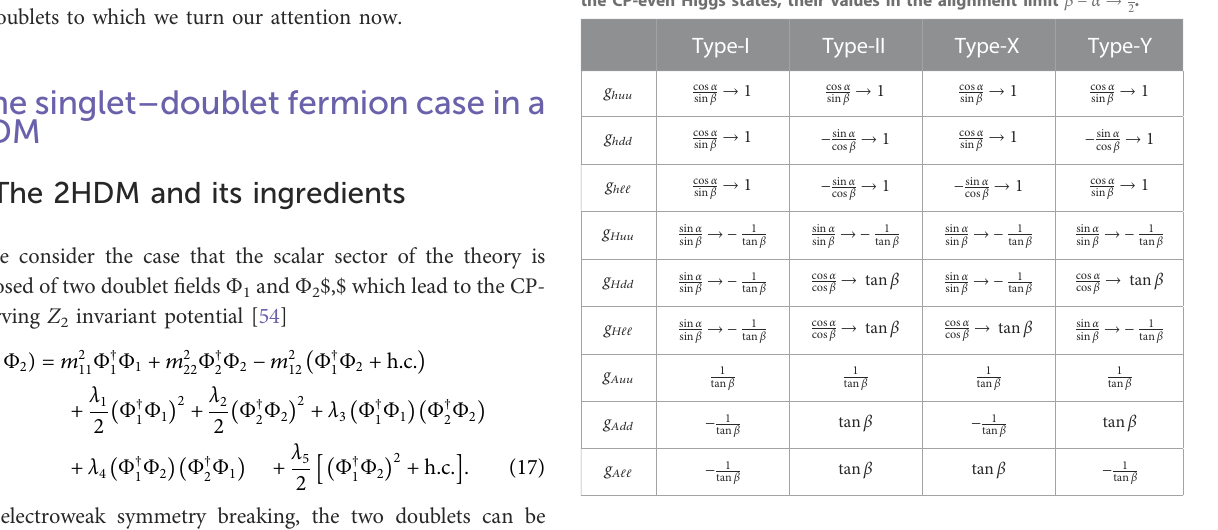
TABLE1Couplingsofthe2HDMHiggsbosonstofermions,normalizedtothose of the SM-like Higgs boson, as a function of the angles α and β . In the case of the CP-even Higgs states, their values in the alignment limit β − α → π